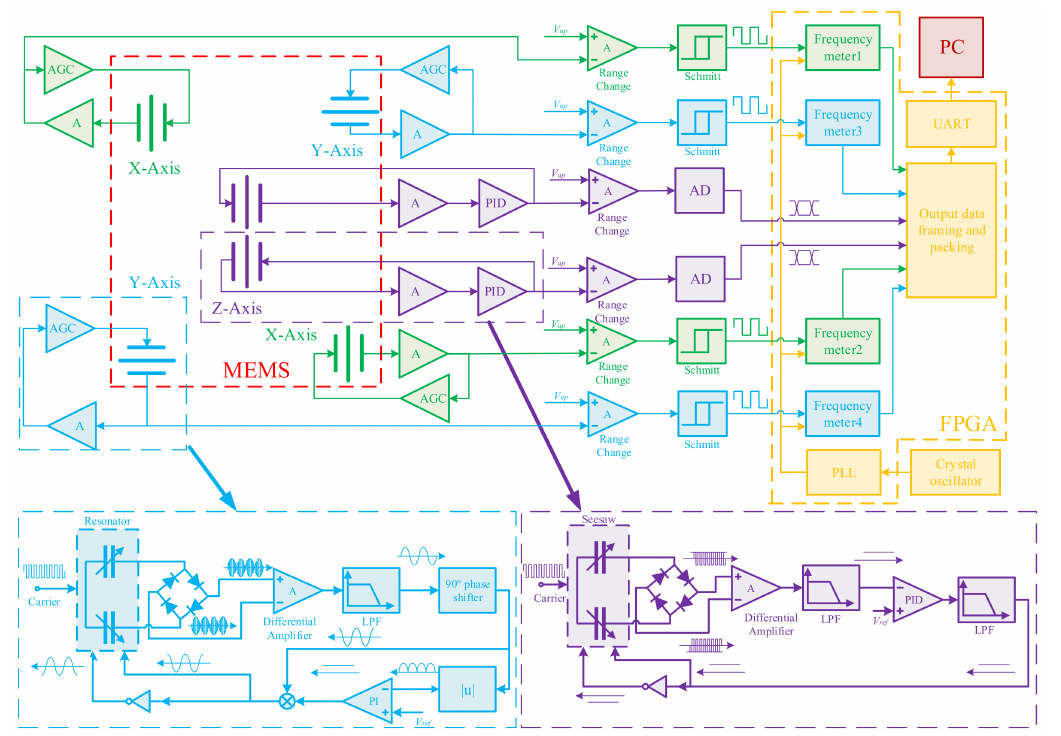
Figure 6. Circuit system of the